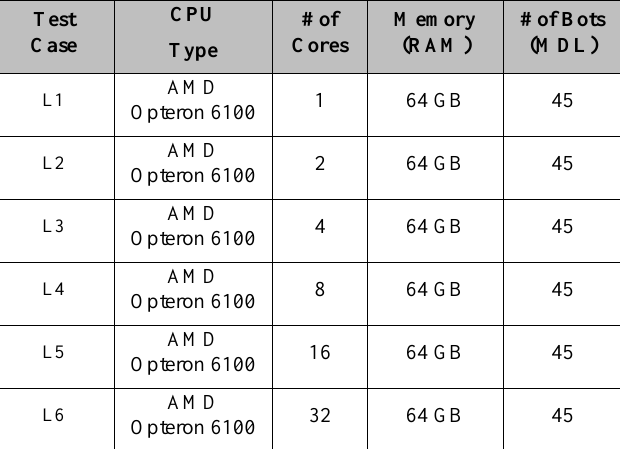
Table 2: Phase 2 Legacy Hardware and Bot Configuration